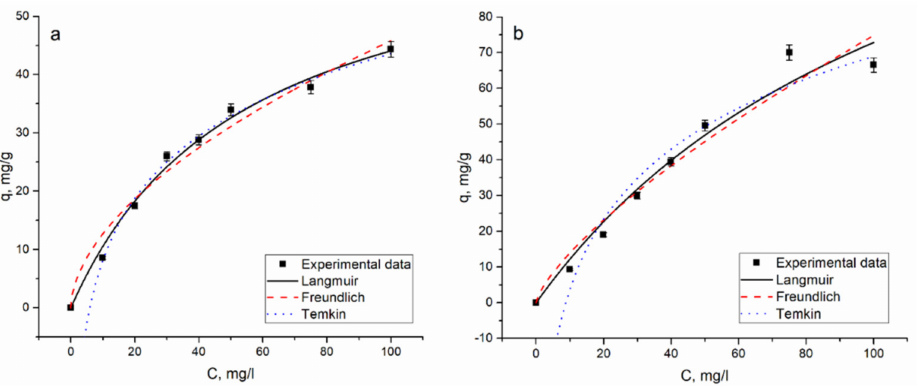
Figure 7. The isotherms describing Ce(III) ion sorption on ( a ) silica SBA-15 and ( b ) titanosilicate ETS-10